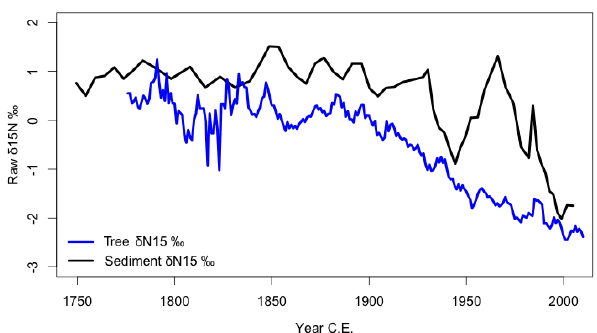
Figure 5. Comparison of sediment 15 N record with a 5-year smoothed raw wood 15 N record. The blue line indicates the wood 15N record (1776–2013), and the black line indicates the sediment 15 N record